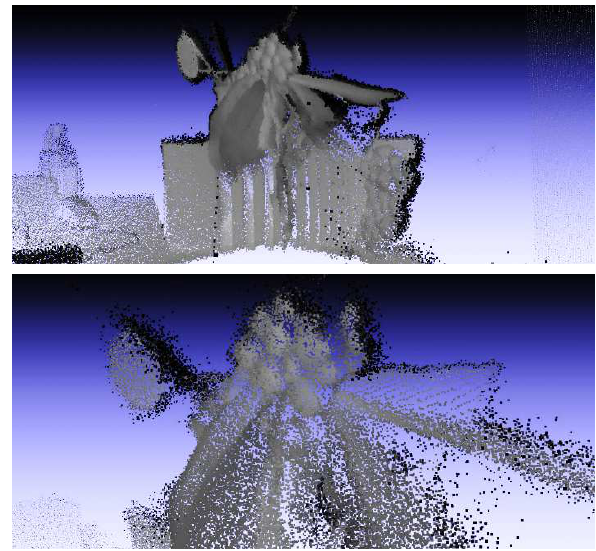
Figure 7: Visualization of the 3D point cloud acquired for the test scenario (top) and zoom on the upper region of interest (bottom).